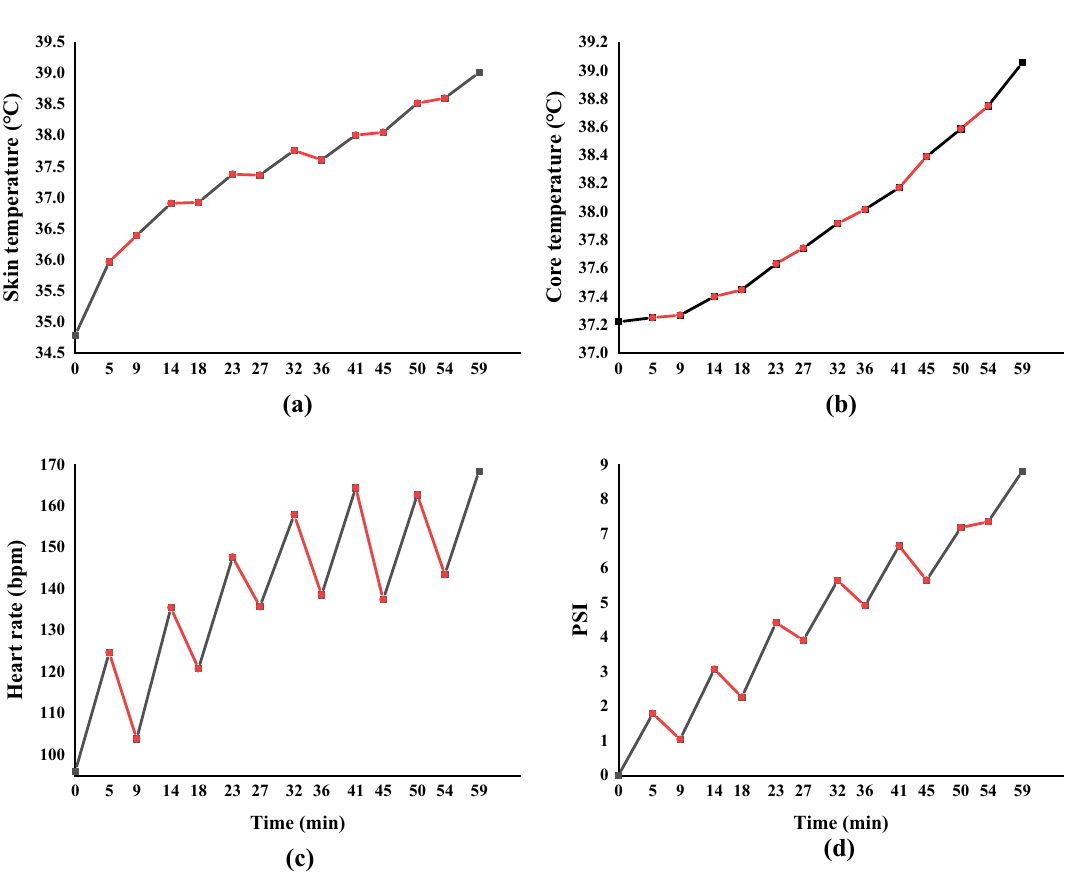
Figure 4. Time course physiological parameters ( T sk , T core , HR , PSI) within FCPE microclimate. Black lines represent sweat collection periods. Red lines represent change pads periods. The figure was created using OriginPro Version(2018C SR1